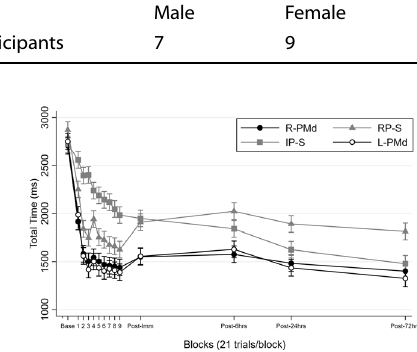
Fig. 2 Total time (ms) for the nine training blocks performed between the baseline (BASE) and immediate posttest (Post-Imm) blocks during which real (R-PMd, L-PMd) or sham (RP-S, IP-S) stimulation was administered during repetitive training (R-PMd, L-PMd, PR-S) and interleaved training (IP-S). No stimulation was present during any tests including 6-h post (Post-6 h), 24-h post (Post-24 h), and 72-h post (Post-72 h). Error bars are standard